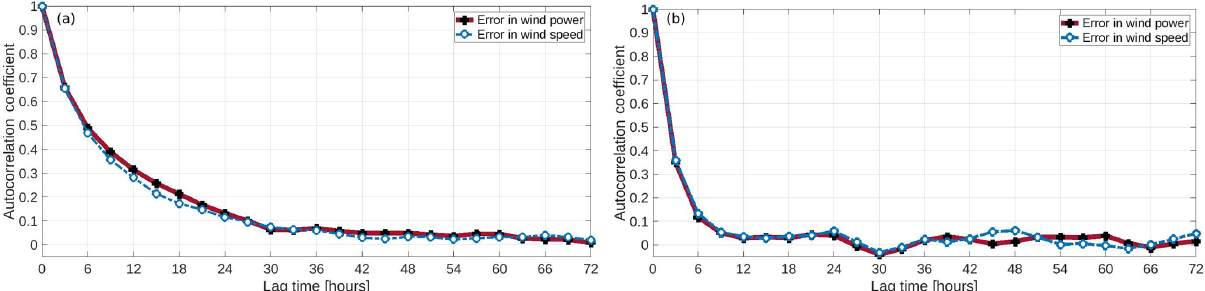
Figure 2. Autocorrelation of wind speed and wind power error in time for (a) park A and (b) park C.